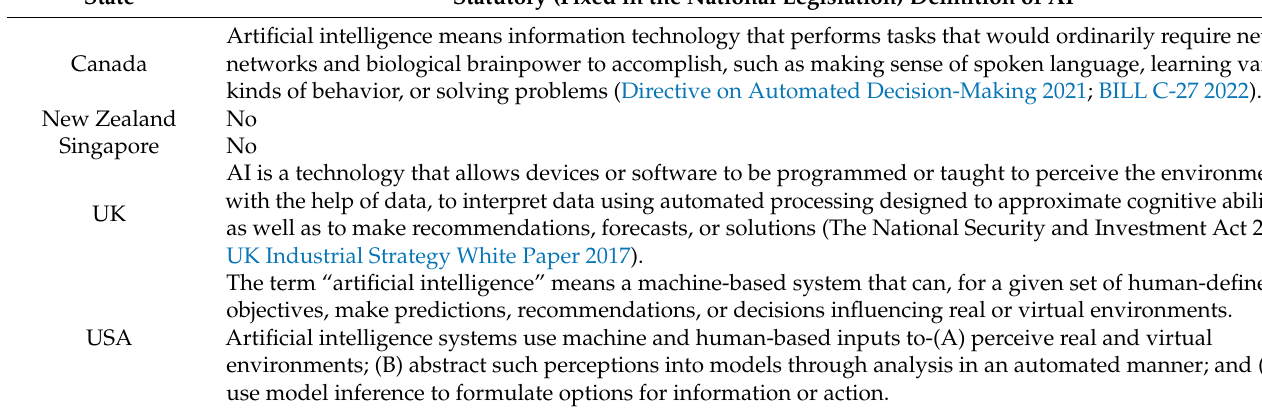
Table 4. Comparative analysis of fixed legislative approaches in the leading countries of the An-glo- Saxon legal system regarding the AI definition (compiled by the